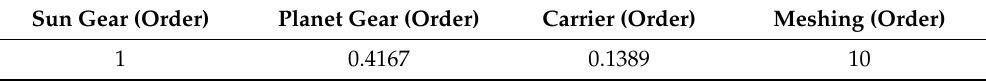
Table 5. Order spectrums of main parameters to the sun gear.